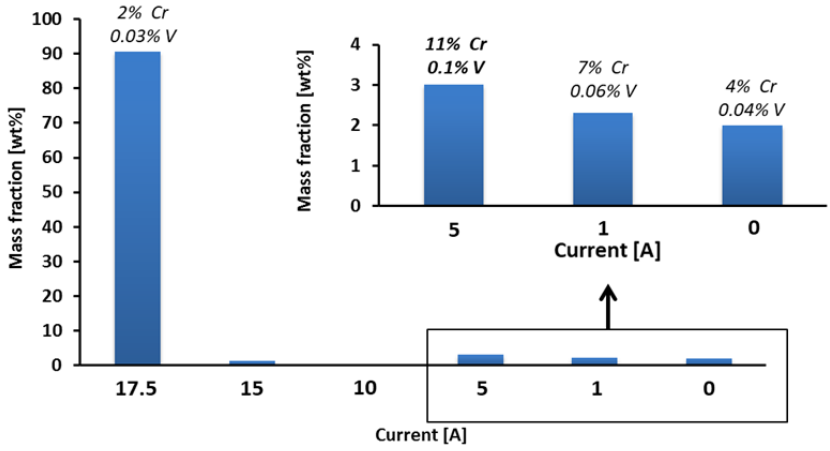
Figure 5. Results of sequential WHIMSe separation for LC FeCr slag-fraction <125 µm.